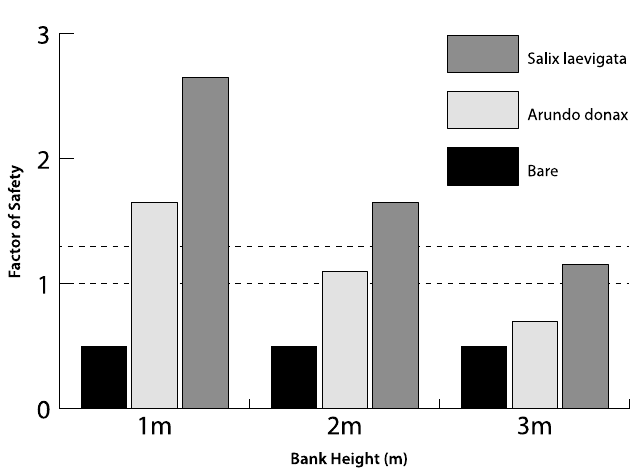
Figure 13. Factor of Safety for a coarse sand bank of 30 degrees, unsaturated conditions with bare bank soils (no vegetation), A. donax vegetation, or S. laevigata vegetation. Dashed lines at FS 1.0 and 1.3 are critical value when driving and resisting forces are equal (FS = 1) and conditional stability (FS = 1.3).